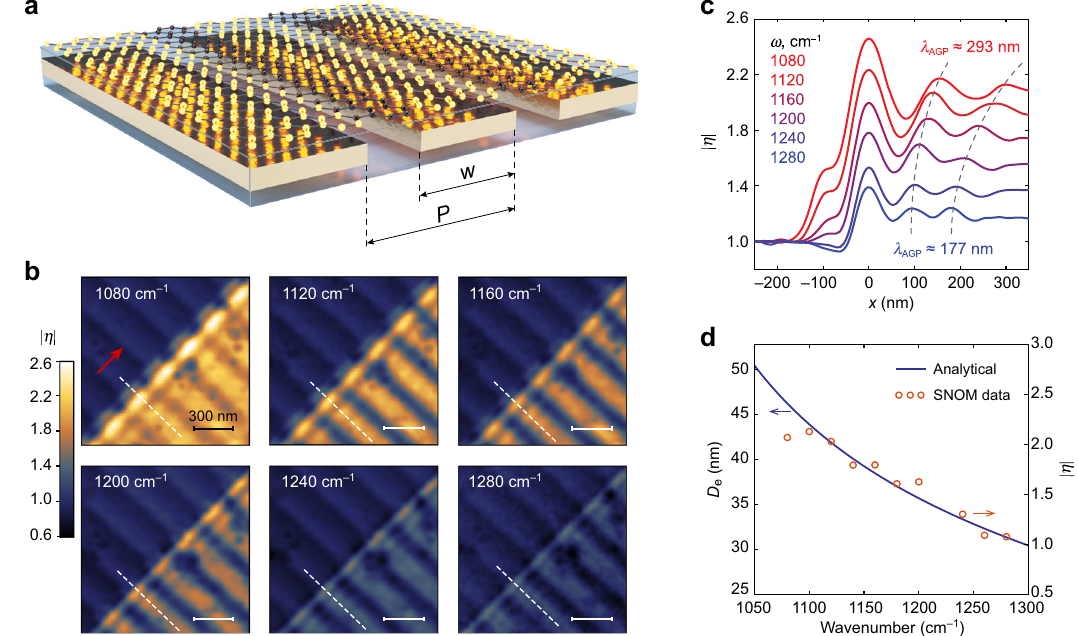
Fig. 4 Near- fi eld imaging of AGP over the periodic array of gold nanoribbons embedded in alumina. a Schematics of the structure with gold nanoribbons of width w arranged in an array with period P . b Near- fi eld contrast η ð x ; y Þ 240 nm, and t = 18 nm. Red arrow indicates the tip illumination direction. c Pro fi le of η (cid:1) (cid:1) (cid:1) (cid:1) at higher excitation frequencies, indicating the stronger AGP con fi nement. d Spectral dependency of maximal η smaller AGP wavelength and η graphene measured far from the edge (circles) and calculated D e (solid) for the sample shown in ( b